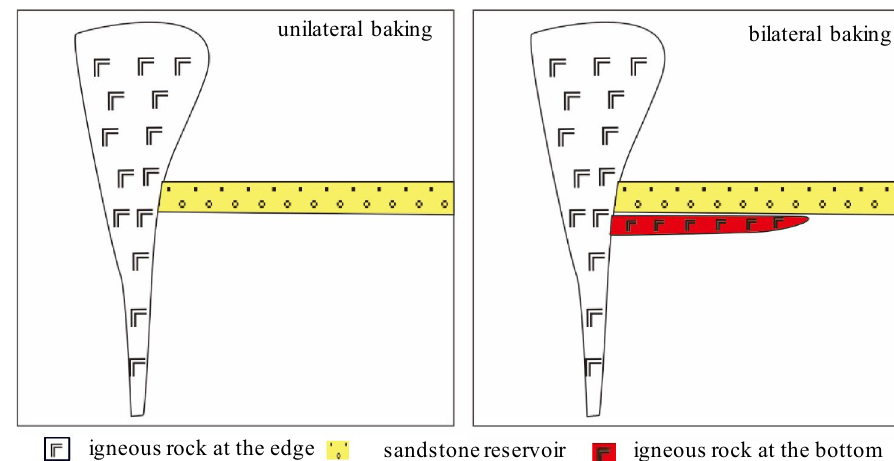
Fig. 10 Oil bearing area of east